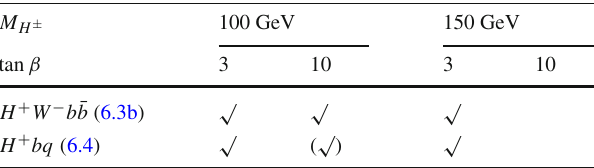
√ , for Models I and X at 30 √ ) requires higher luminosity